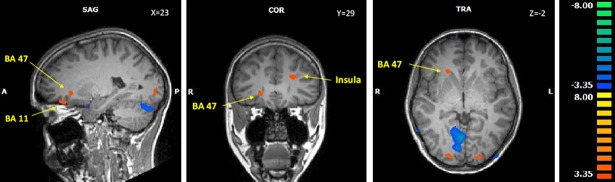
Activation differences between adolescent AN patients and controls for high-calorie stimuli.The color marking shows the t-values of the activation contrast between AN patients and controls. Positive values (red to yellow scale) mark brain areas with higher BOLD changes in AN while negative values (blue to green scale) mark areas with higher BOLD changes in controls.